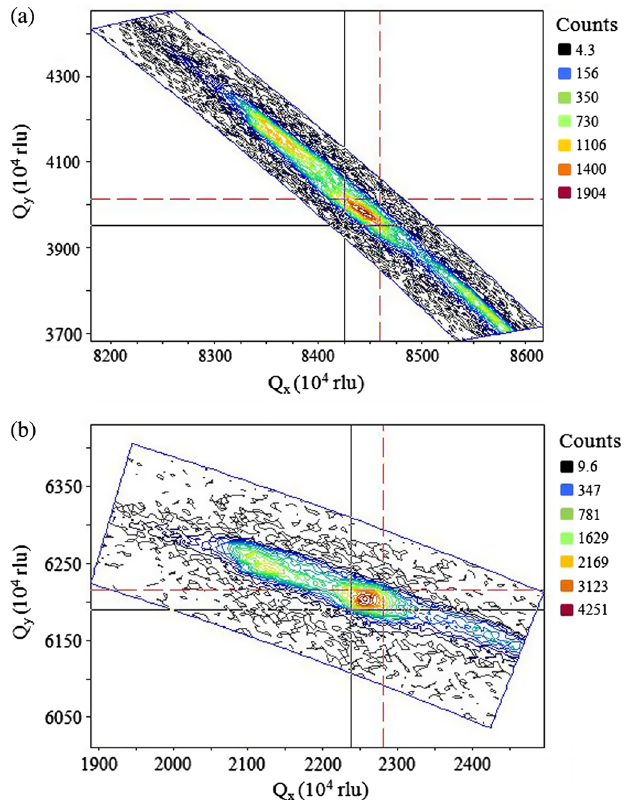
O measured on sample FIG. 25. Reciprocal space maps of Nb (1 1 0) pole measured 3 5 on sample L51 with low (a) and high (b) x-ray angle of